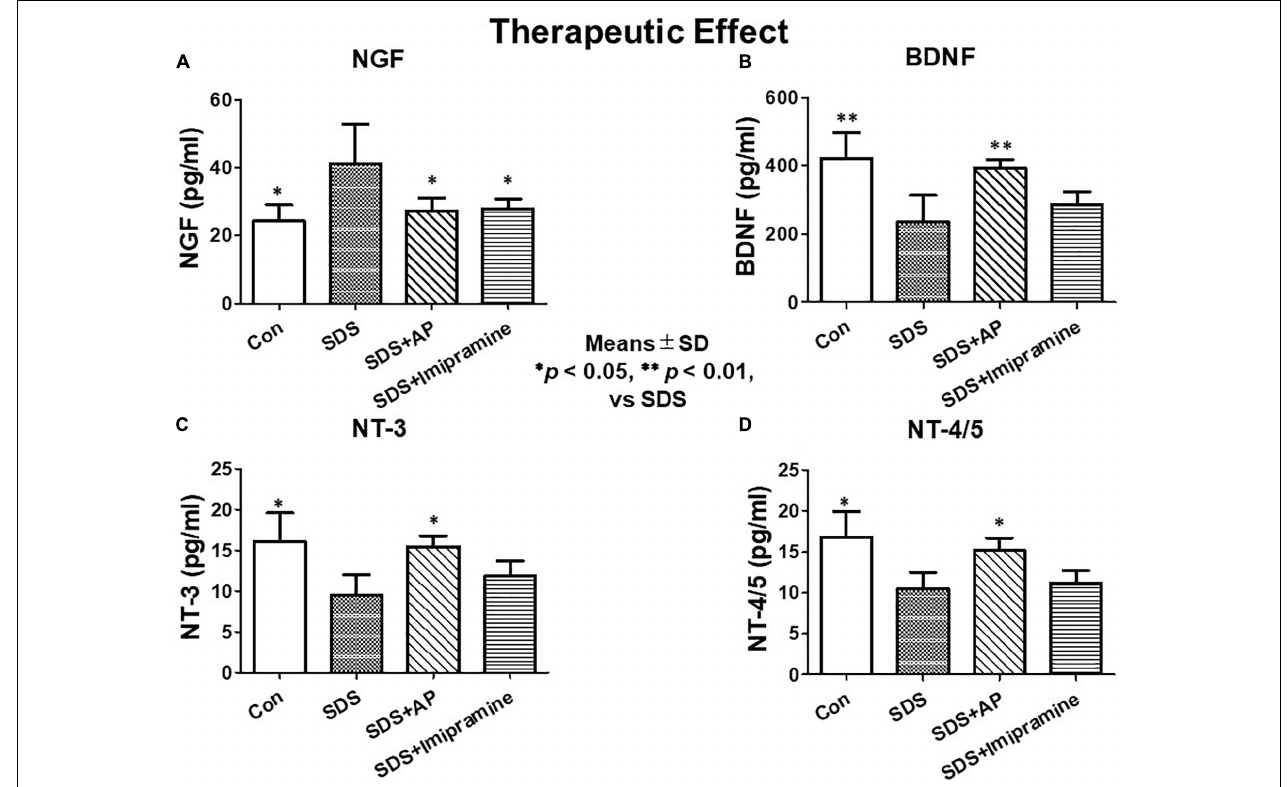
FIGURE 10 | Expressions of neurotrophic factors in the brain after treatment of depression in SDS mice. (A) NGF, (B) BDNF, (C) NT-3, (D) NT-4/5. Results are expressed as protein content measured by ELISA. Values are means ± SD ( n = 8). ∗ p < 0.05 and ∗∗ p < 0.01 versus SDS group. AP, acupuncture; BDNF, brain-derived neurotrophic factor; NGF, nerve growth factor; NT, neurotrophin; SD, standard deviation; SDS, social defeat